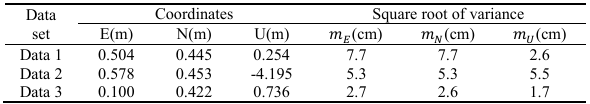
Table 3 . Calculate normally.